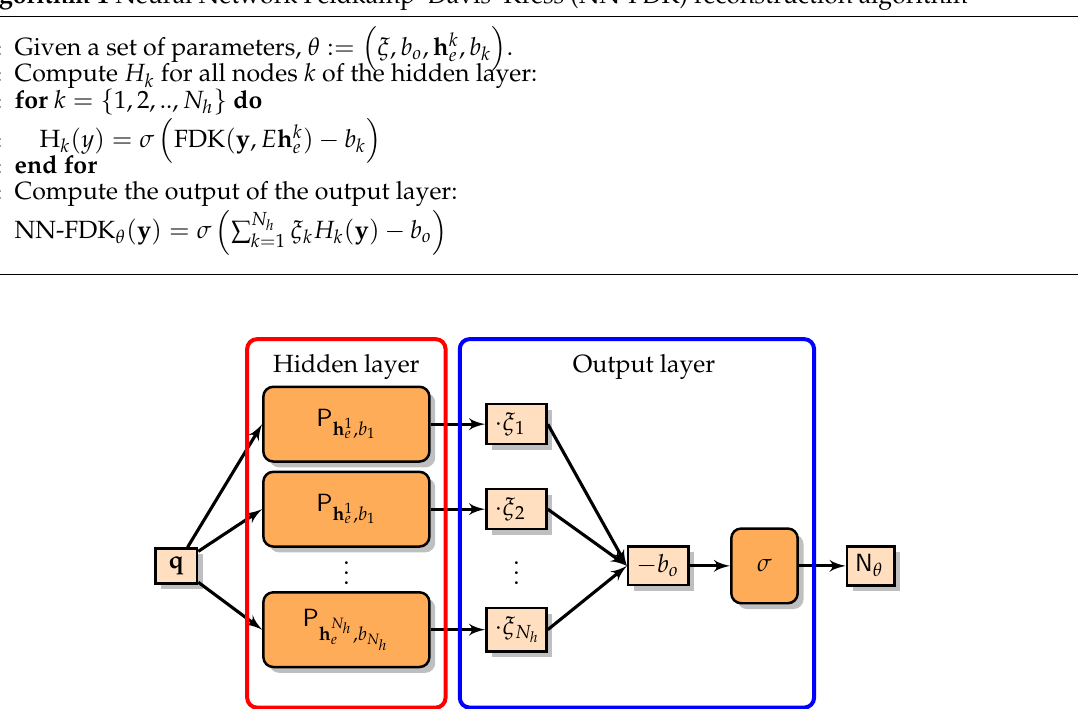
R , with N h hidden →